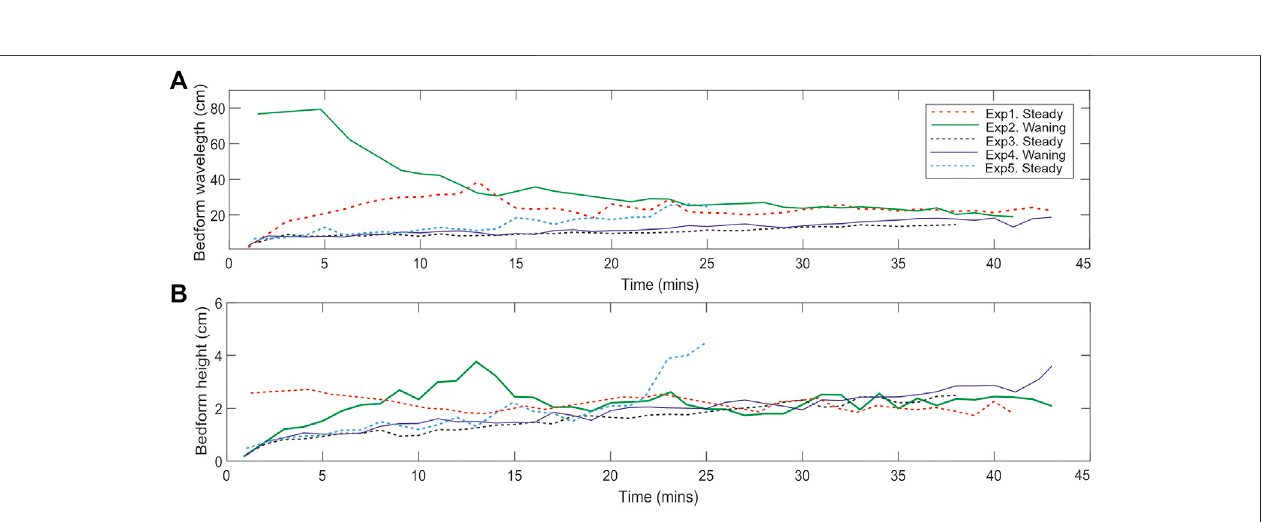
FIGURE 9 | Average height and wavelength of bedforms measured every 30 s in a 2-m-wide window located 4 – 6 m from the upstream end of channel. (A) Bedform wavelength. (B) Bedform height. Steady fl ow experiments depicted by dashed lines. Waning fl ow experiments depicted by solid lines.